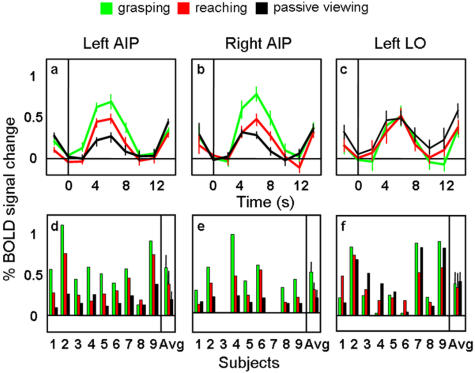
Percent of BOLD signal change (% BSC) for Experiment 2 in the left AIP (a,d), in the right AIP (b,e) and in the left LO (c,f) localized by Experiment 1.
a,b,c) Line graphs indicate the event‐related averaged time courses in % BSC with time zero indicating visual stimuli onset. d,e,f) Bar graphs display the magnitude of peak activation in %BSC in each of the three experimental conditions at the level of single subject and group average (the rightmost bars). Right and left AIP (a,b,d,e) responded to grasping, reaching, and passive viewing, even though higher for grasping. LO (c,f) was equally activated by grasping, reaching, and passive viewing.